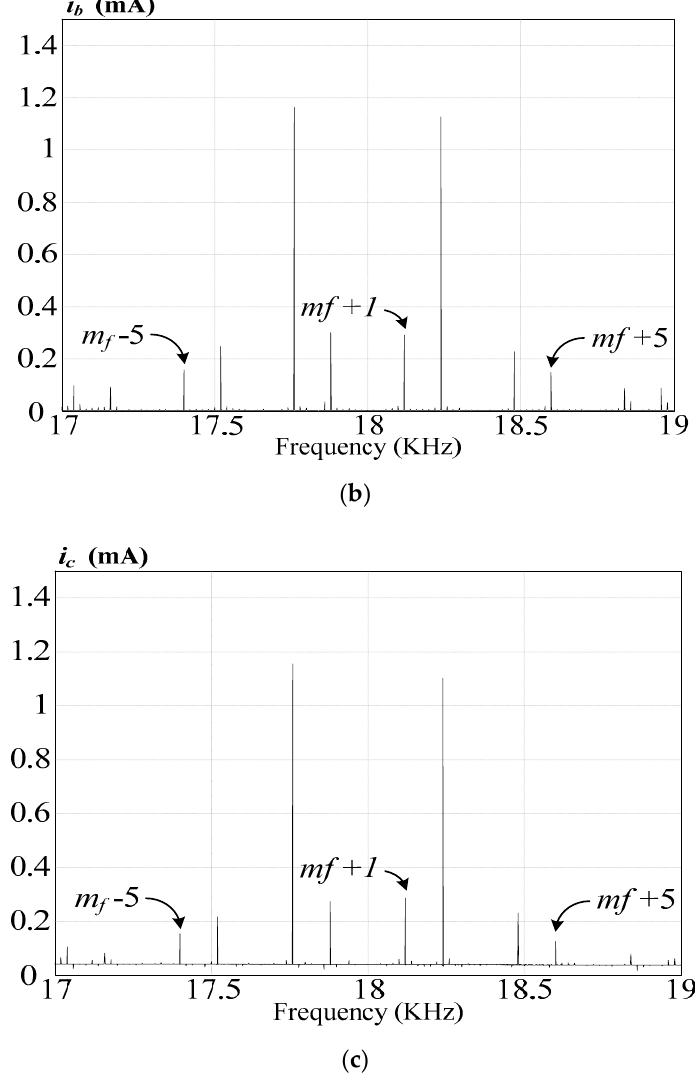
Figure 4. Frequency spectra of line currents for an inverter working at 60 Hz without any faulty switches: ( a ) line current i a ; ( b ) line current i b ; ( c ) line current i c .